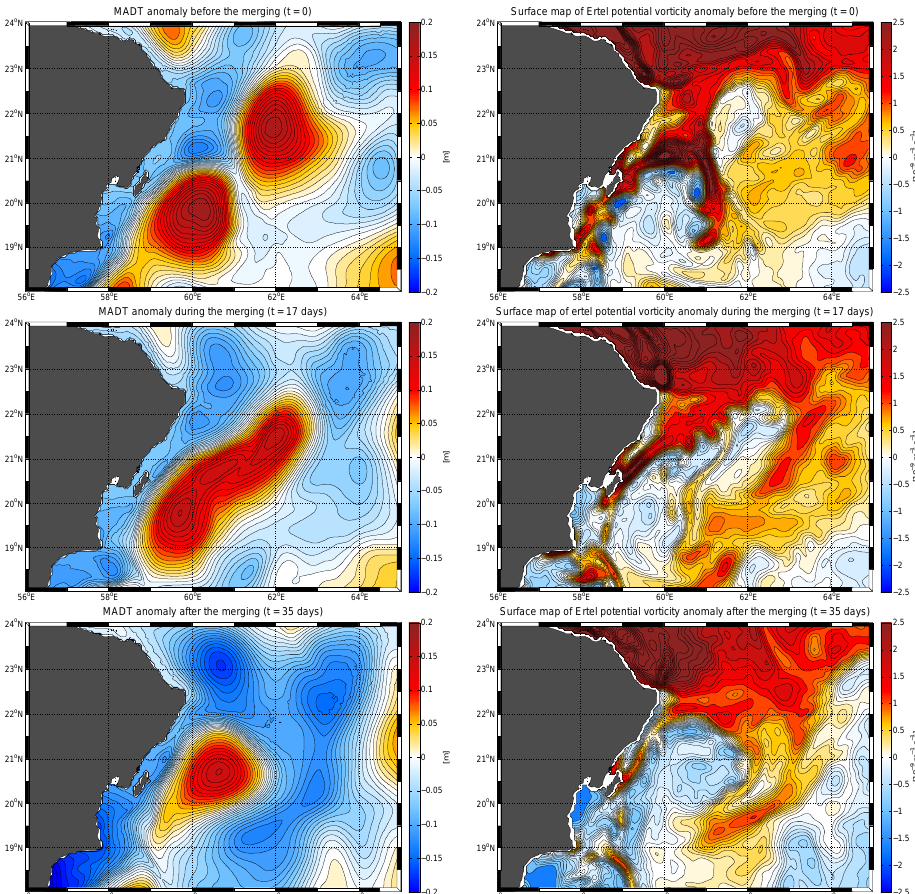
Figure 15. Evolution of the altimetry anomaly (left) and Ertel potential vorticity anomaly (right) during a merger of two anticyclones along the Oman Coastal Current for t = 0 (top), t = 17 days (center), and t = 35 days (bottom). The Ertel potential vorticity anomaly field is strongly positive north of 22 ◦ N due to a strong front of density in